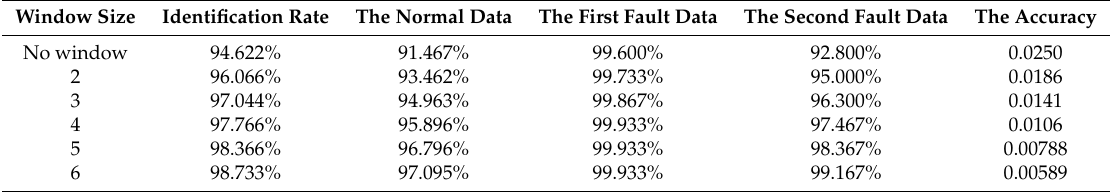
Table 1. The relationship between the sliding window size and fault identification